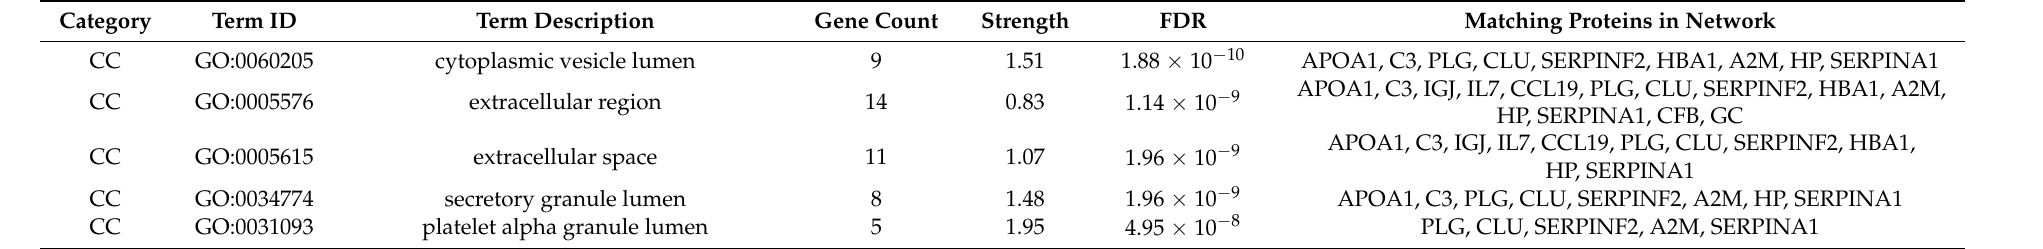
Table 7. The most significant GO terms within cellular component (CC), molecular function (MF), and biological process (BP) for CPT in